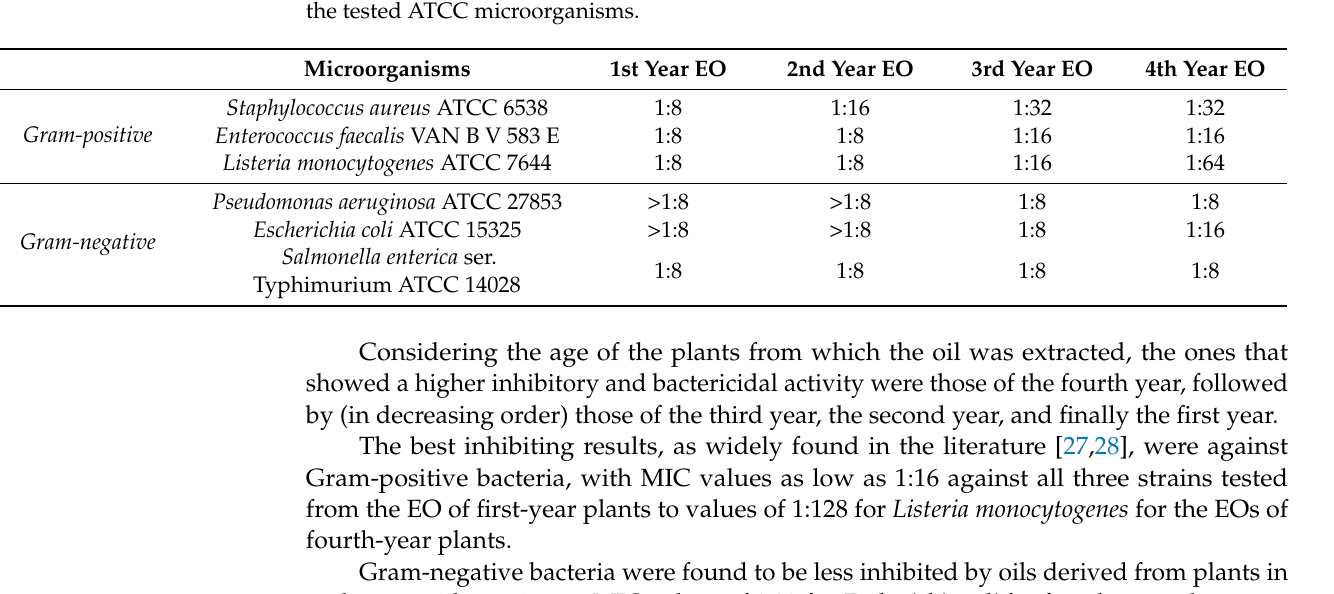
Table 5. Mode of minimum bactericidal concentration (MBC) of lavender essential oils (EOs) against the tested ATCC